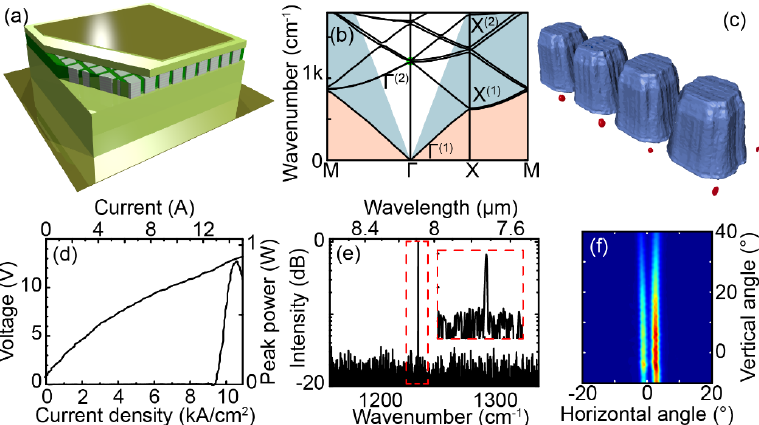
Figure 10. Buried photonic crystal QCLs. ( a ) Schematic illustration of the buried photonic crystal QCL. ( b ) Photonic crystal band structure, in which the most important symmetry points are indicated; ( c ) three-dimensional representation of a PhC structure, reconstructed from a focused ion beam SEM image stack; and ( d ) light current voltage characteristic of the photonic crystal QCL recorded at −20 °C. ( e ) Laser spectrum of the photonic crystal QC; and ( f ) far field intensity pattern of the photonic crystal QCL.